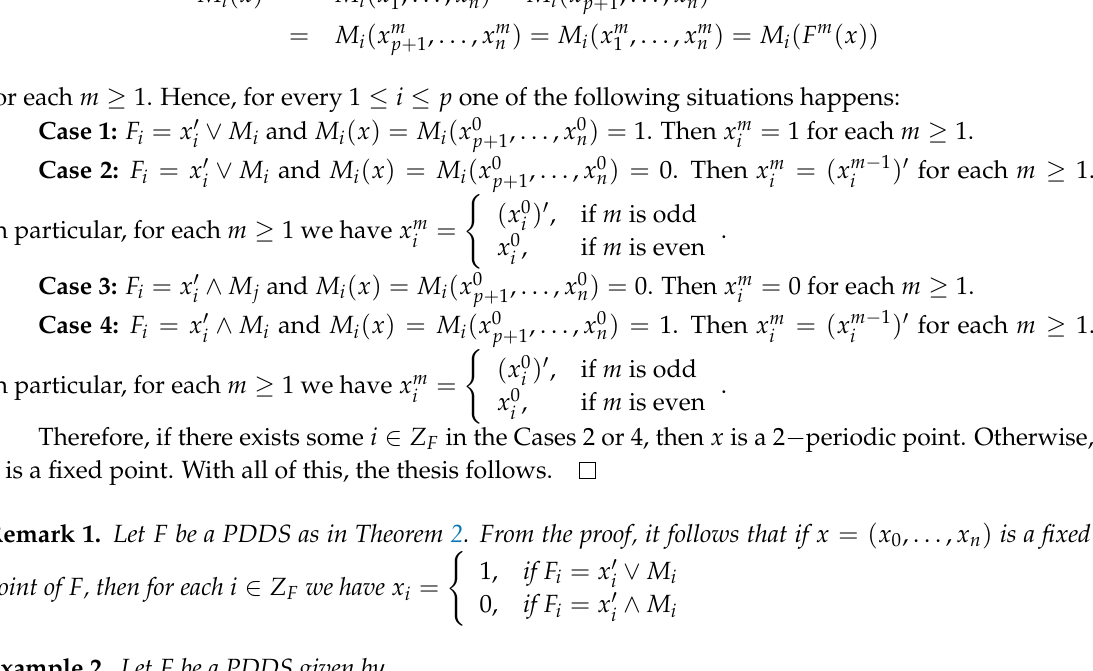
∨ x (cid:48) ) , x ∨ x ) 3 1 3 1